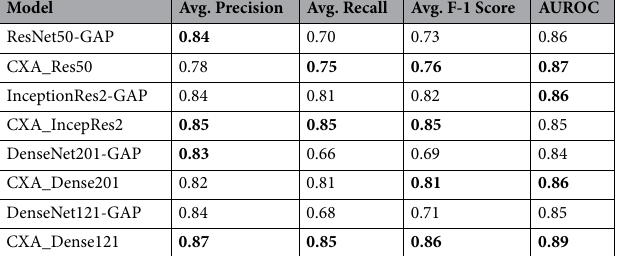
Table 5. The performance comparison on the test dataset of the base-model-gap with the base-model-amm to the average precision, average recall, average f-1 score and auroc scores. Significant values are in bold.